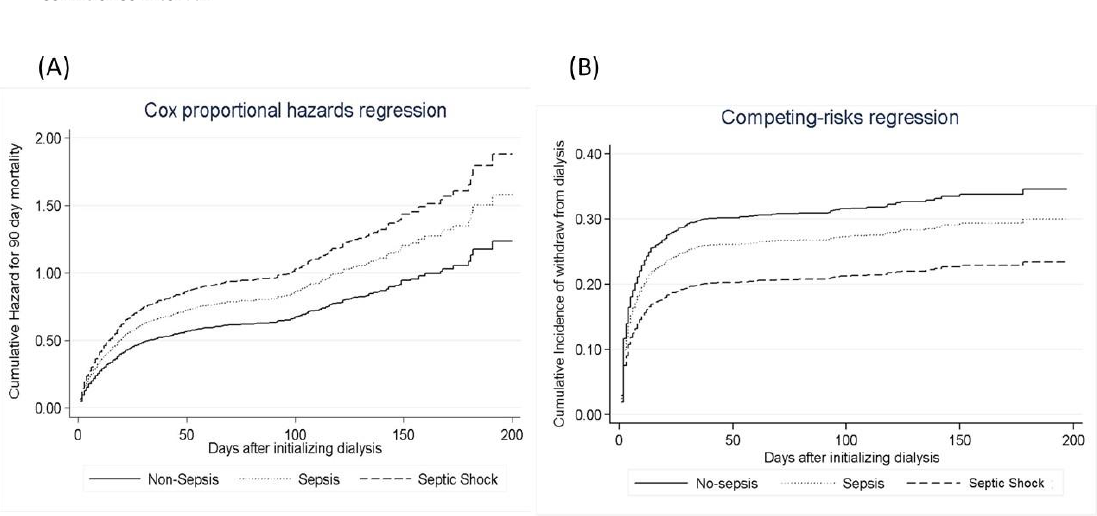
Figure 2. Cox proportional hazards models. ( A ) Cox proportional hazards models are plotted to model the probability of free from 90 days mortality, stratified by Sepsis-3 status. ( B ) Model the risk of chronic dialysis, taking mortality as a competing risk.